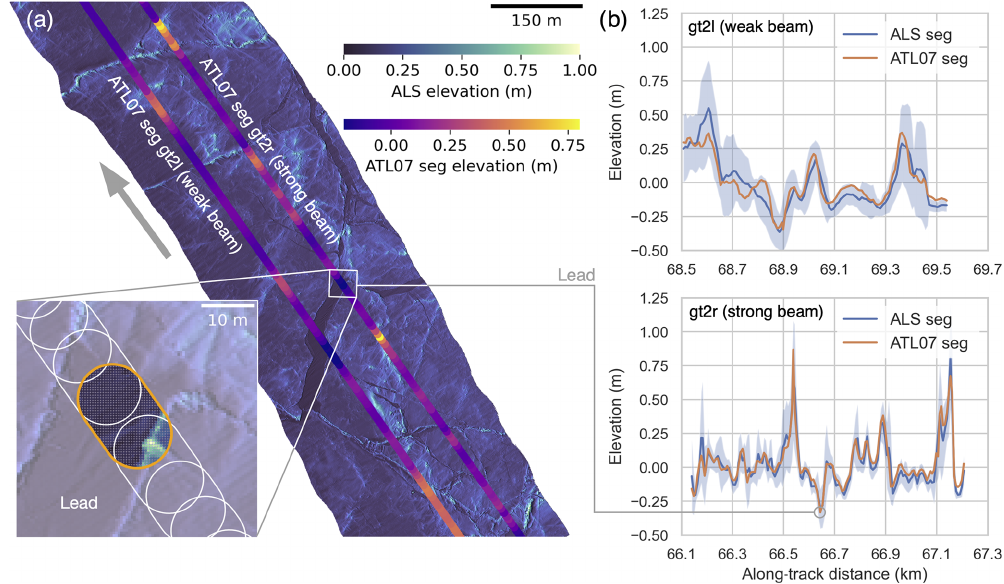
Figure 2. (a) Profile section (1km) of the airborne laser scanner (ALS) swath with overlapping ICESat-2 beams after drift correction. The zoomed-in box shows the ICESat-2 segment outlines in white and one segment highlighted in orange, with matching ALS point measure- ments inside, corresponding to a lead. The gray arrow indicates the flight direction of the helicopter. (b) Elevation profiles, along the overlap shown in panel (a) , of ICESat-2 beams and coincident ALS elevation, averaged within the corresponding ICESat-2 ATL07 segments. The blue shaded area in the elevation profiles represents the standard deviation of ALS point measurements within